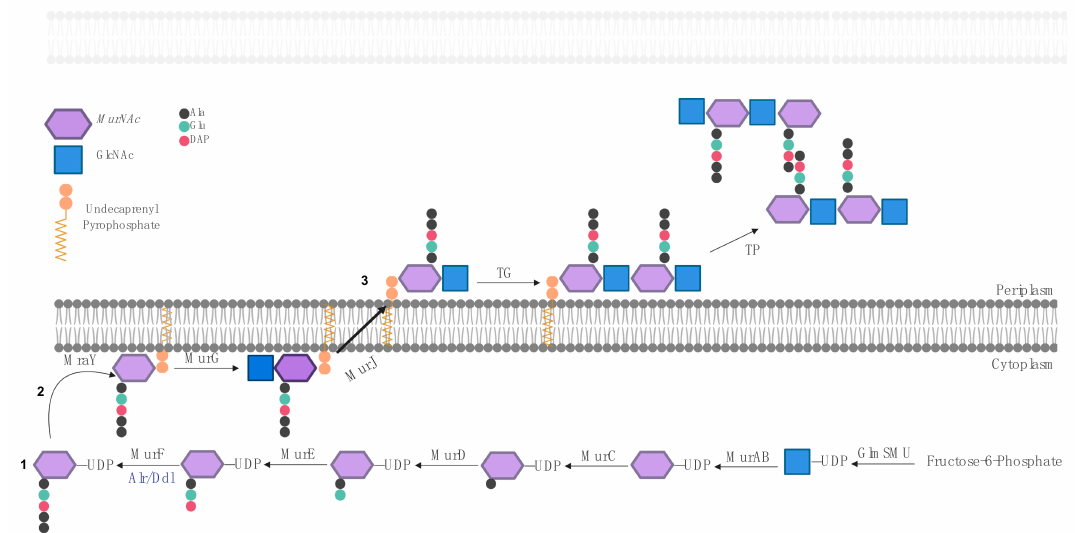
Figure 2. Schematic representation of PGN biosynthesis in Gram-negative bacteria: ( 1 ) synthesis of a PG precursor in the cytoplasm; ( 2 ) synthesis of lipid-linked precursors at the inner leaflet of the cytoplasmatic membrane; ( 3 ) flipping to the outer leaflet of the cytoplasmatic membrane and incorporation of the precursor into nascent PGN by transglycosylation (TG) and transpeptidation (TP) reactions. Enzymes shown in blue synthesize substrates added on the depicted reaction: Alr racemases convert l -Ala to d -Ala and Ddl ligases form the d -Ala- d -Ala